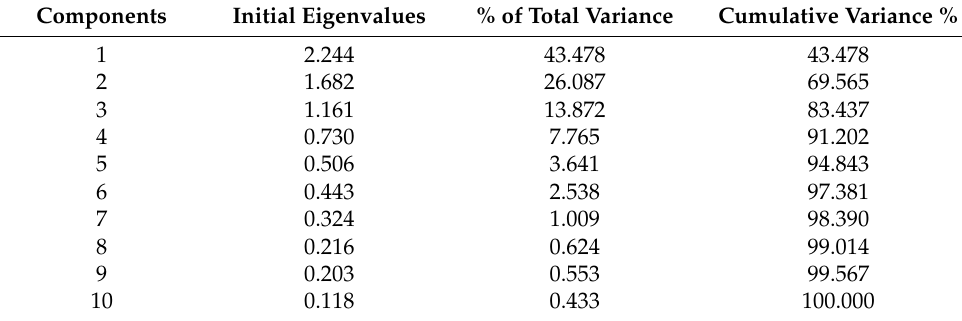
Table 1. Results of the factor analysis and the variance explained.